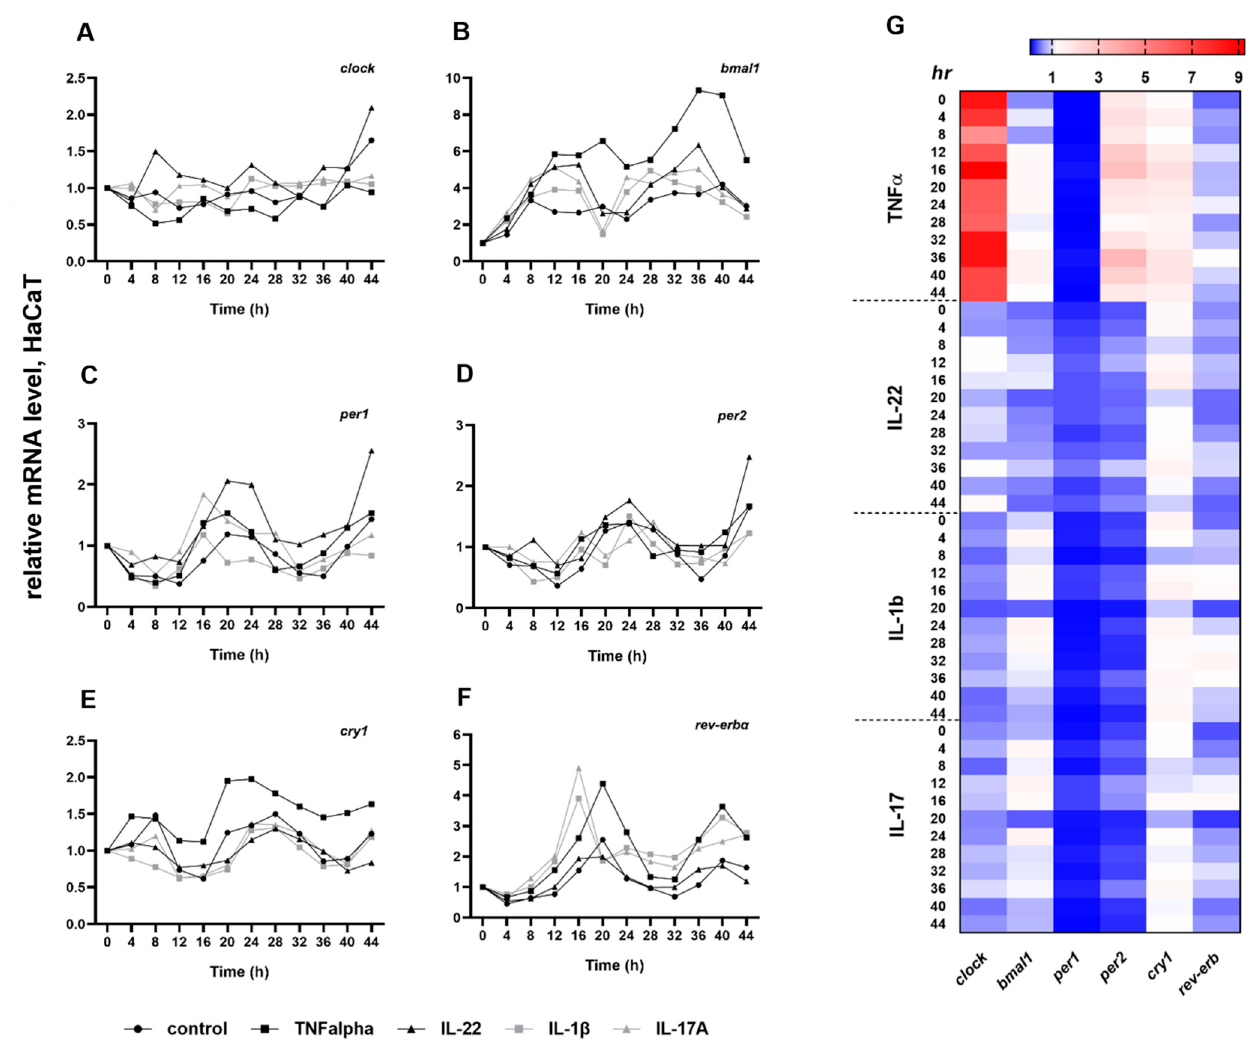
Figure 3. Circadian entrainment in HaCaT keratinocytes. ( A – F ) The effects of cytokines on the circadian entrainment in HaCaT keratinocytes. Data are plotted as means only. The statistical significance of differences was analyzed by two-way ANOVA followed by Dunnett’s post hoc test. The results of two-way ANOVA are described in Table S1. ( G ) Heatmap expression plot of selected clock genes. Rows represent time points and columns represent genes.